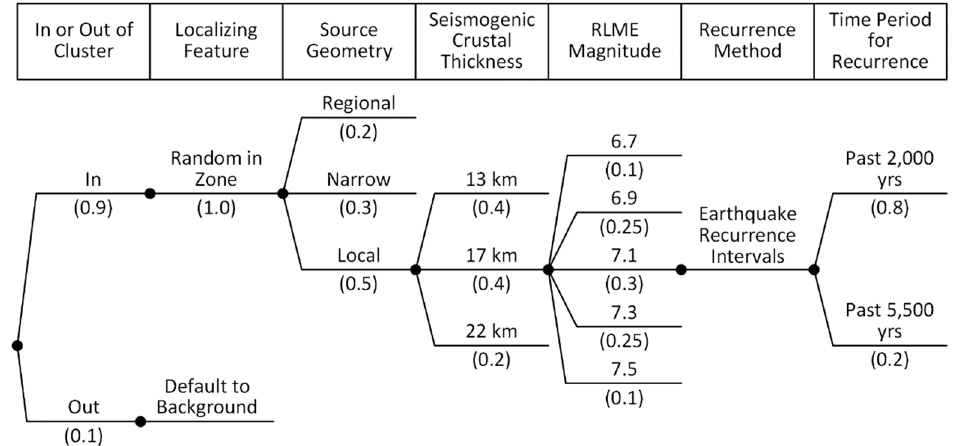
Figure 26. Charleston seismic zone logic tree of seismic source model in CEUS SSC Project (modified from Reference [35]). Paleoliquefaction data are reflected in clustered behavior and in recurrence data used in seismic source model.